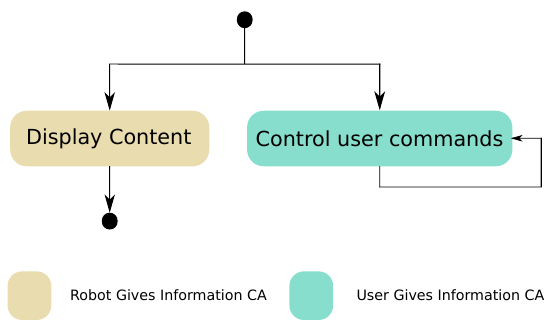
Figure 6. Flow diagram for the manage multimedia content CCA. This CCA sends the content to the touch screen and allows the user to control the execution of the content with voice